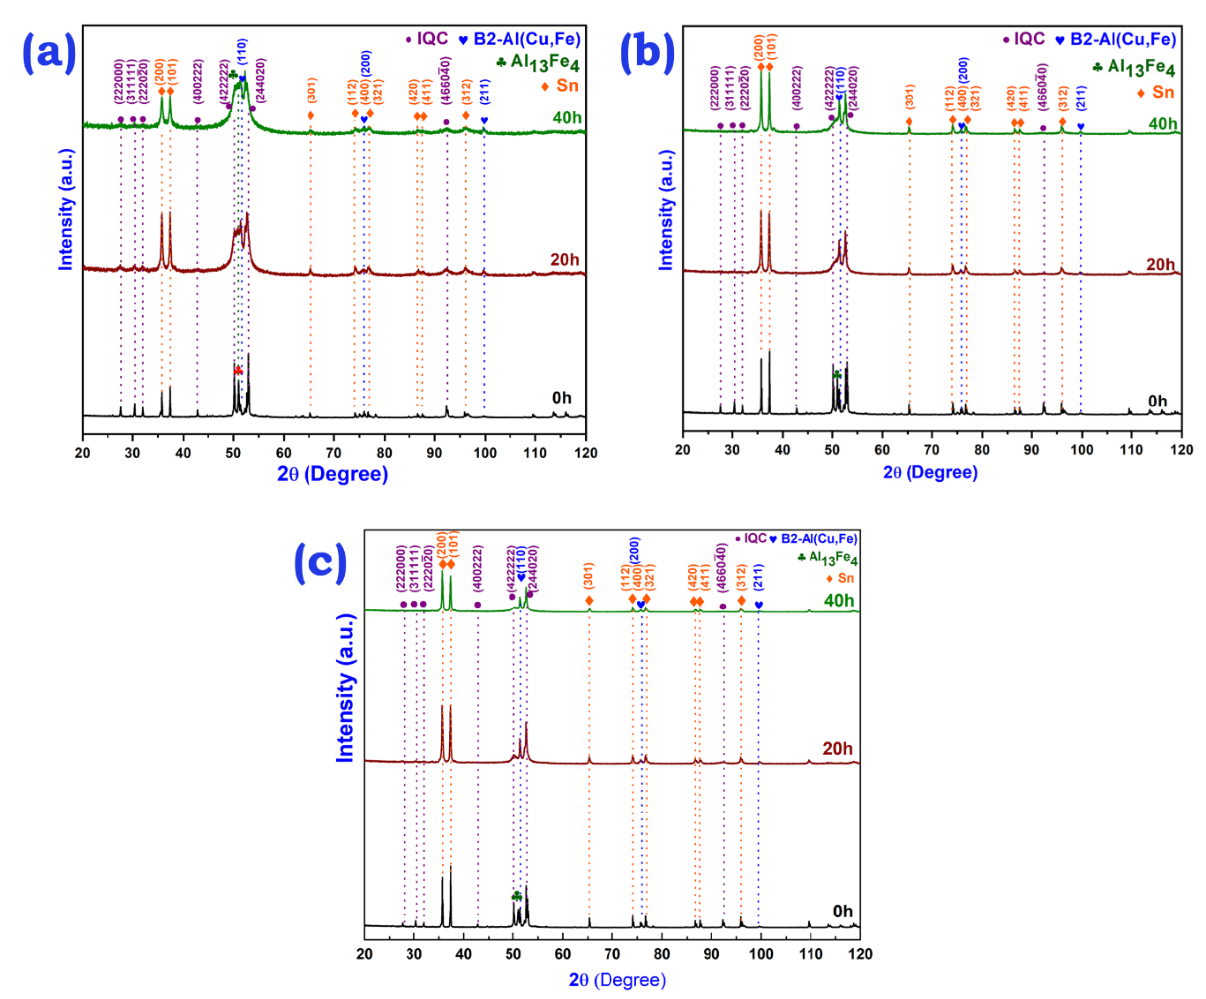
Figure 2. Phase analysis of ( a ) IQC-10Sn, ( b ) IQC-20Sn and ( c ) IQC-30Sn nanocomposite powders mechanically milled up to 40 h.